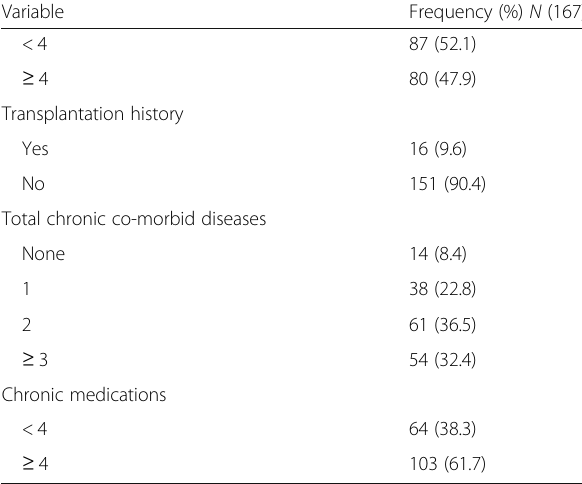
Table 1 Demographic and clinical characteristics of the